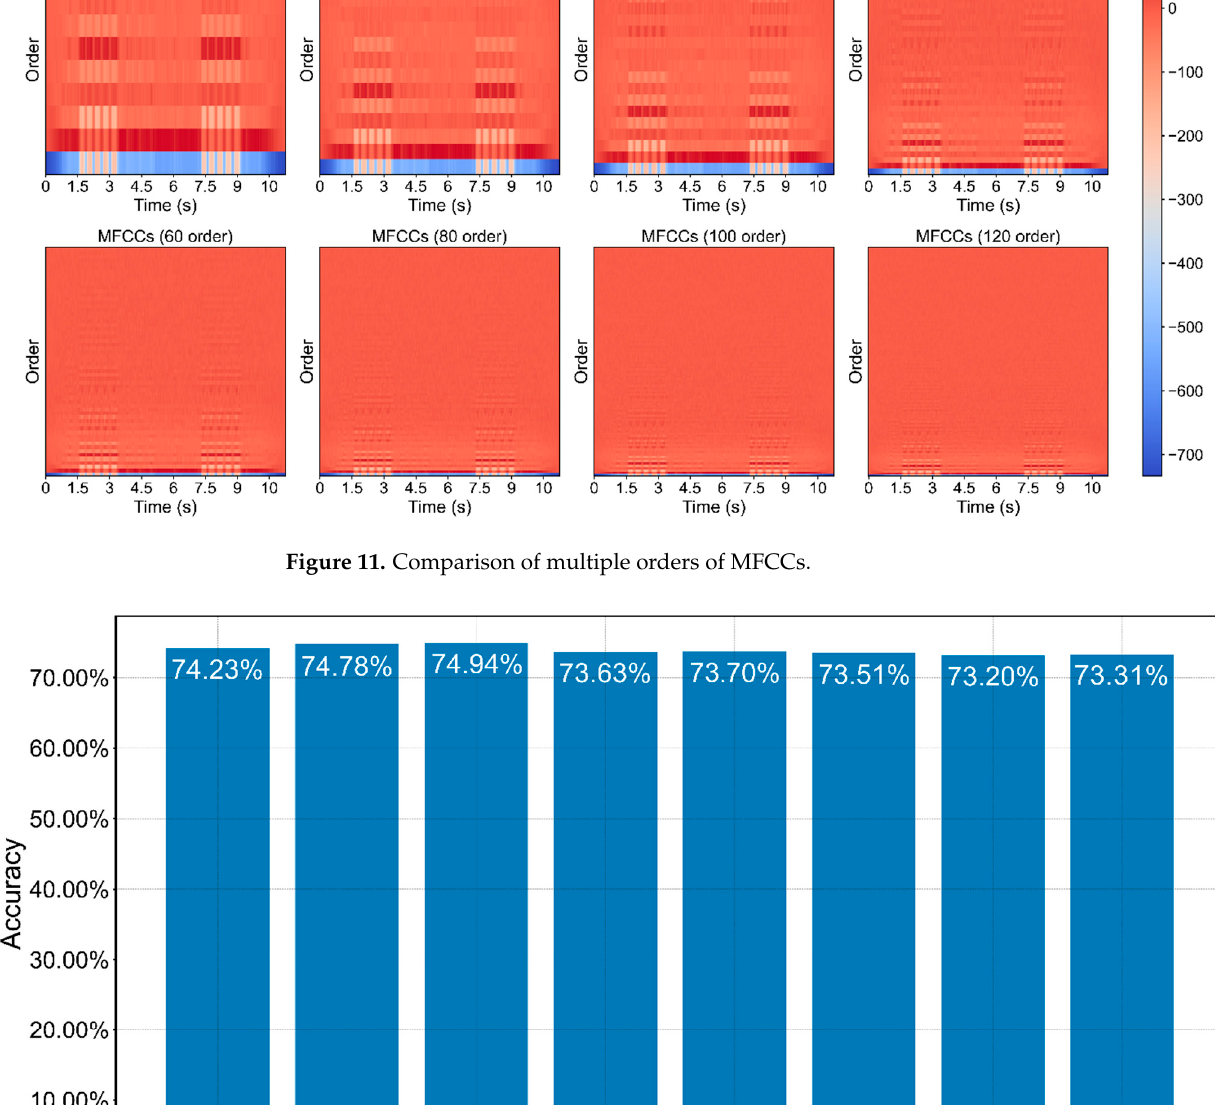
Figure 10. Distribution of performance scores by data volume.